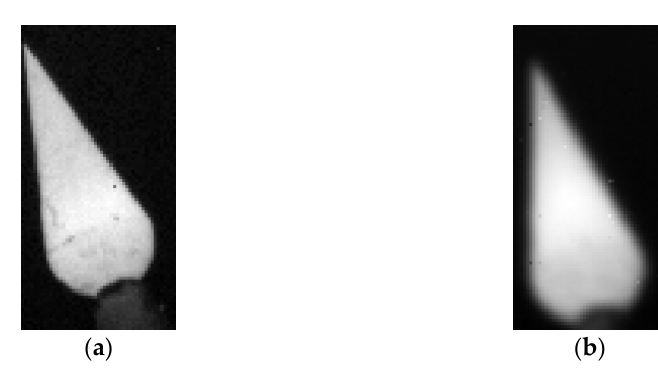
Figure 16. Infrared images after reshaping; ( a ) 8–11.7 µm; ( b ) 3–5 µm.